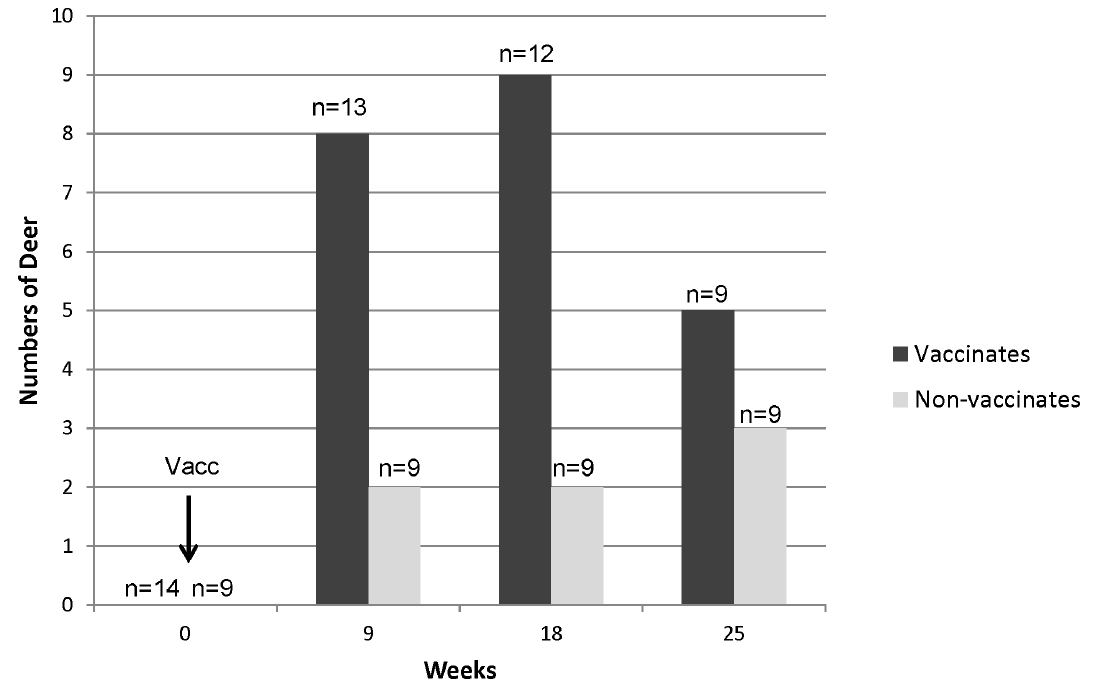
Figure 1. Numbers of CCT reactor white-tailed deer at four time points. Numbers of vaccinated and non-vaccinated white-tailed deer of total tested that were comparative cervical skin test reactors as measured at four time points.